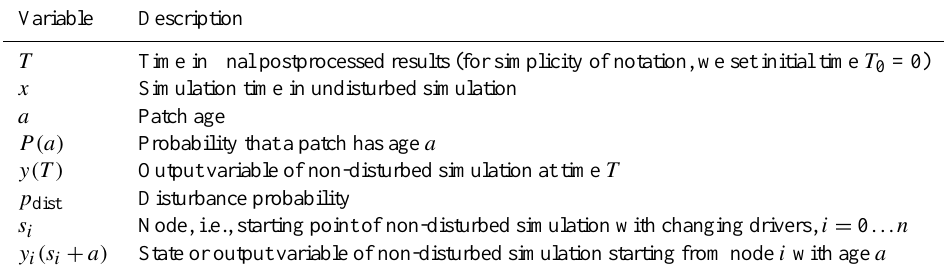
Table 1. Variables appearing in the